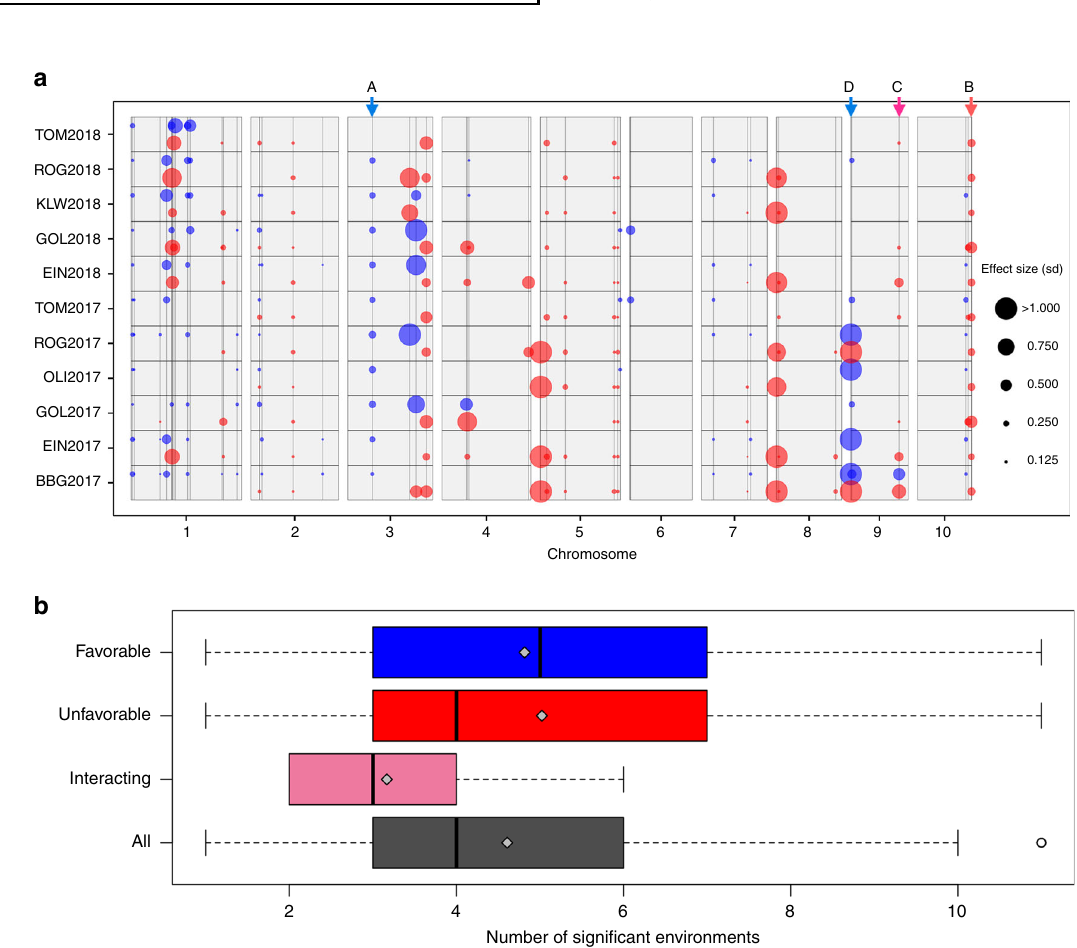
Fig. 3 Effect stability of focus haplotypes across environments. a Genomic position as well as effect size, and direction for 48 haplotypes associated with PH_V6 across 11 environments. Circles indicate signi fi cant haplotypes with effect sizes given in phenotypic standard deviations. Positive and negative effects are colored in blue and red, respectively. Arrows at the top indicate the positions of haplotypes described in Supplementary Fig. 5. b Number of environments in which favorable ( n = 65), unfavorable ( n = 93), interacting ( n = 36), and all ( n = 194) haplotypes had signi fi cant effects on four early plant development traits (EV_V4, EV_V6, PH_V4, and/or PH_V6). Boxplots show the upper and lower quartile, median (bold vertical bar), mean (gray diamond), and whiskers (dashed horizontal lines). Points outside the whiskers indicate values ±1.5 times the interquartile range. Source data are provided as a Source data fi le.